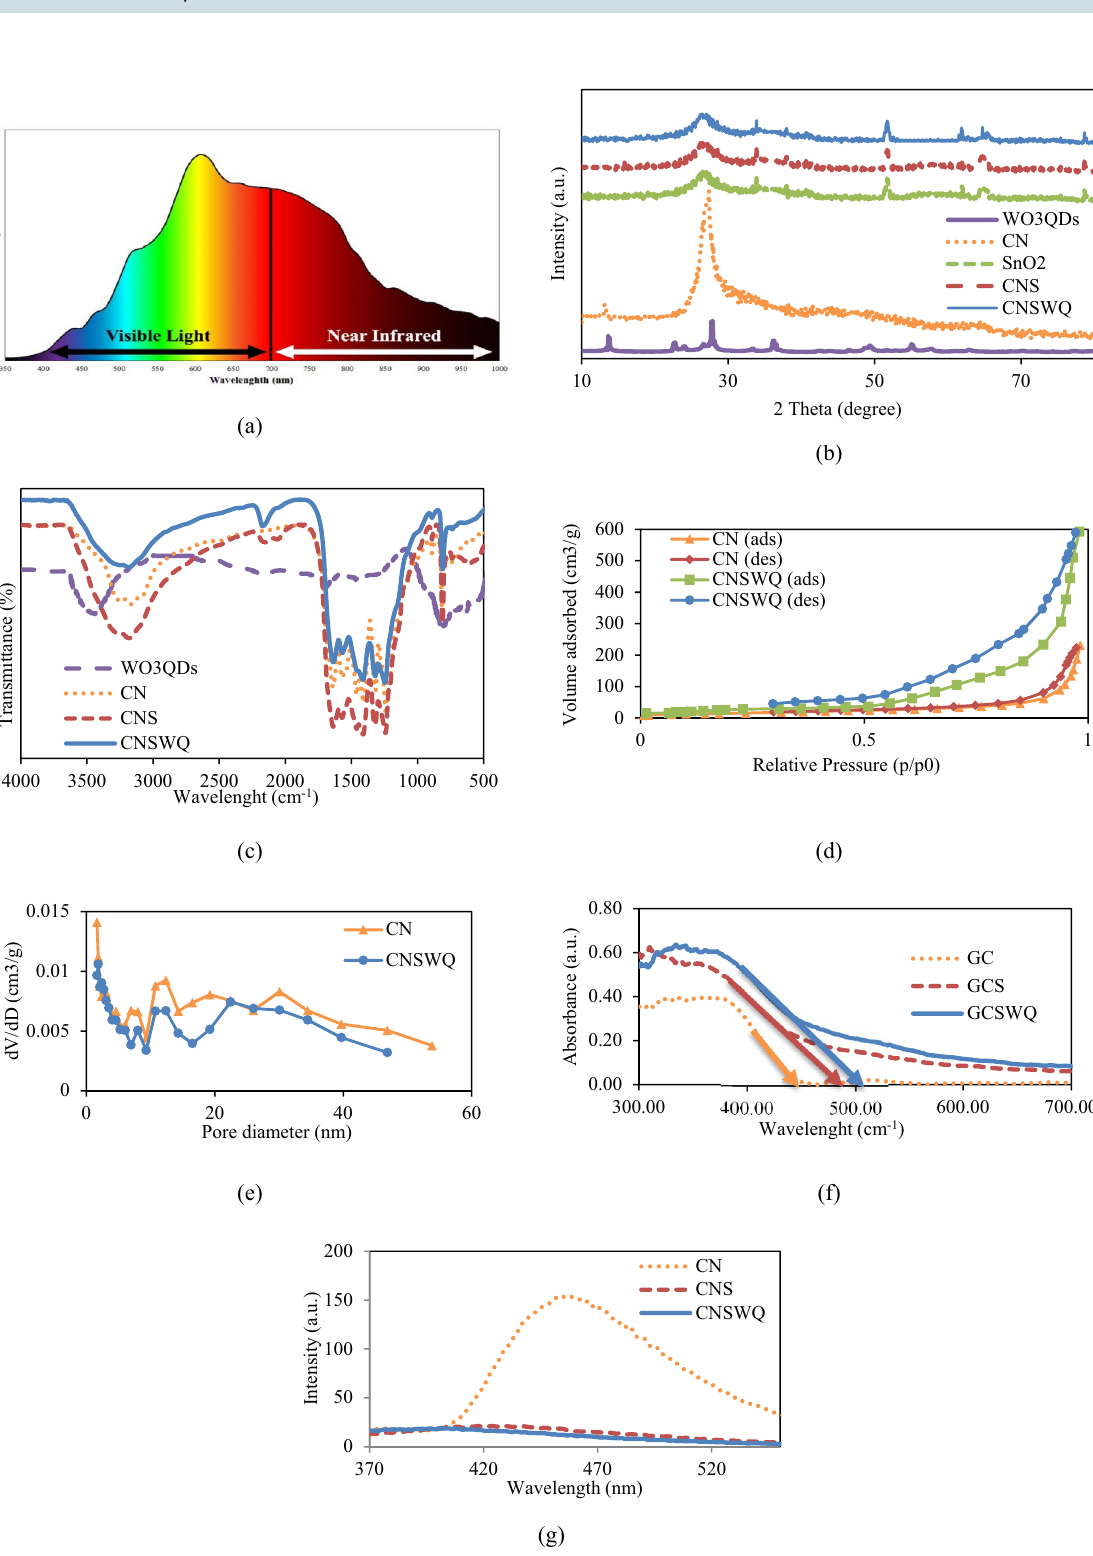
Figure 1. ( a ) Emission spectra of the lamp, ( b ) XRD, ( c ) FTIR spectra, ( d ) N 2 adsorption–desorption curves, ( e ) BET surface area, ( f ), UV–Vis spectra, and ( g ) PL spectra of the